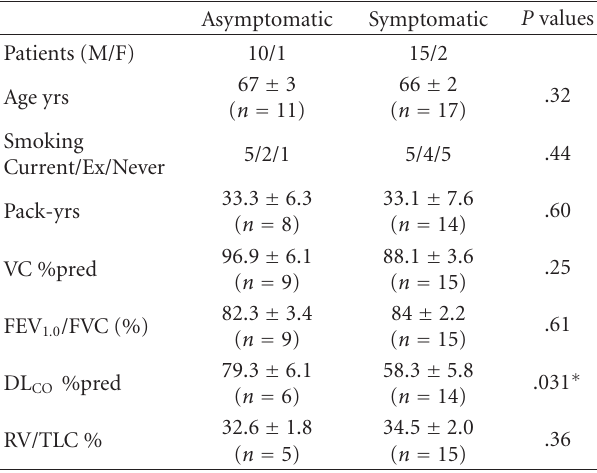
Table 1: Characteristics of asymptomatic and symptomatic patients with honeycombing on